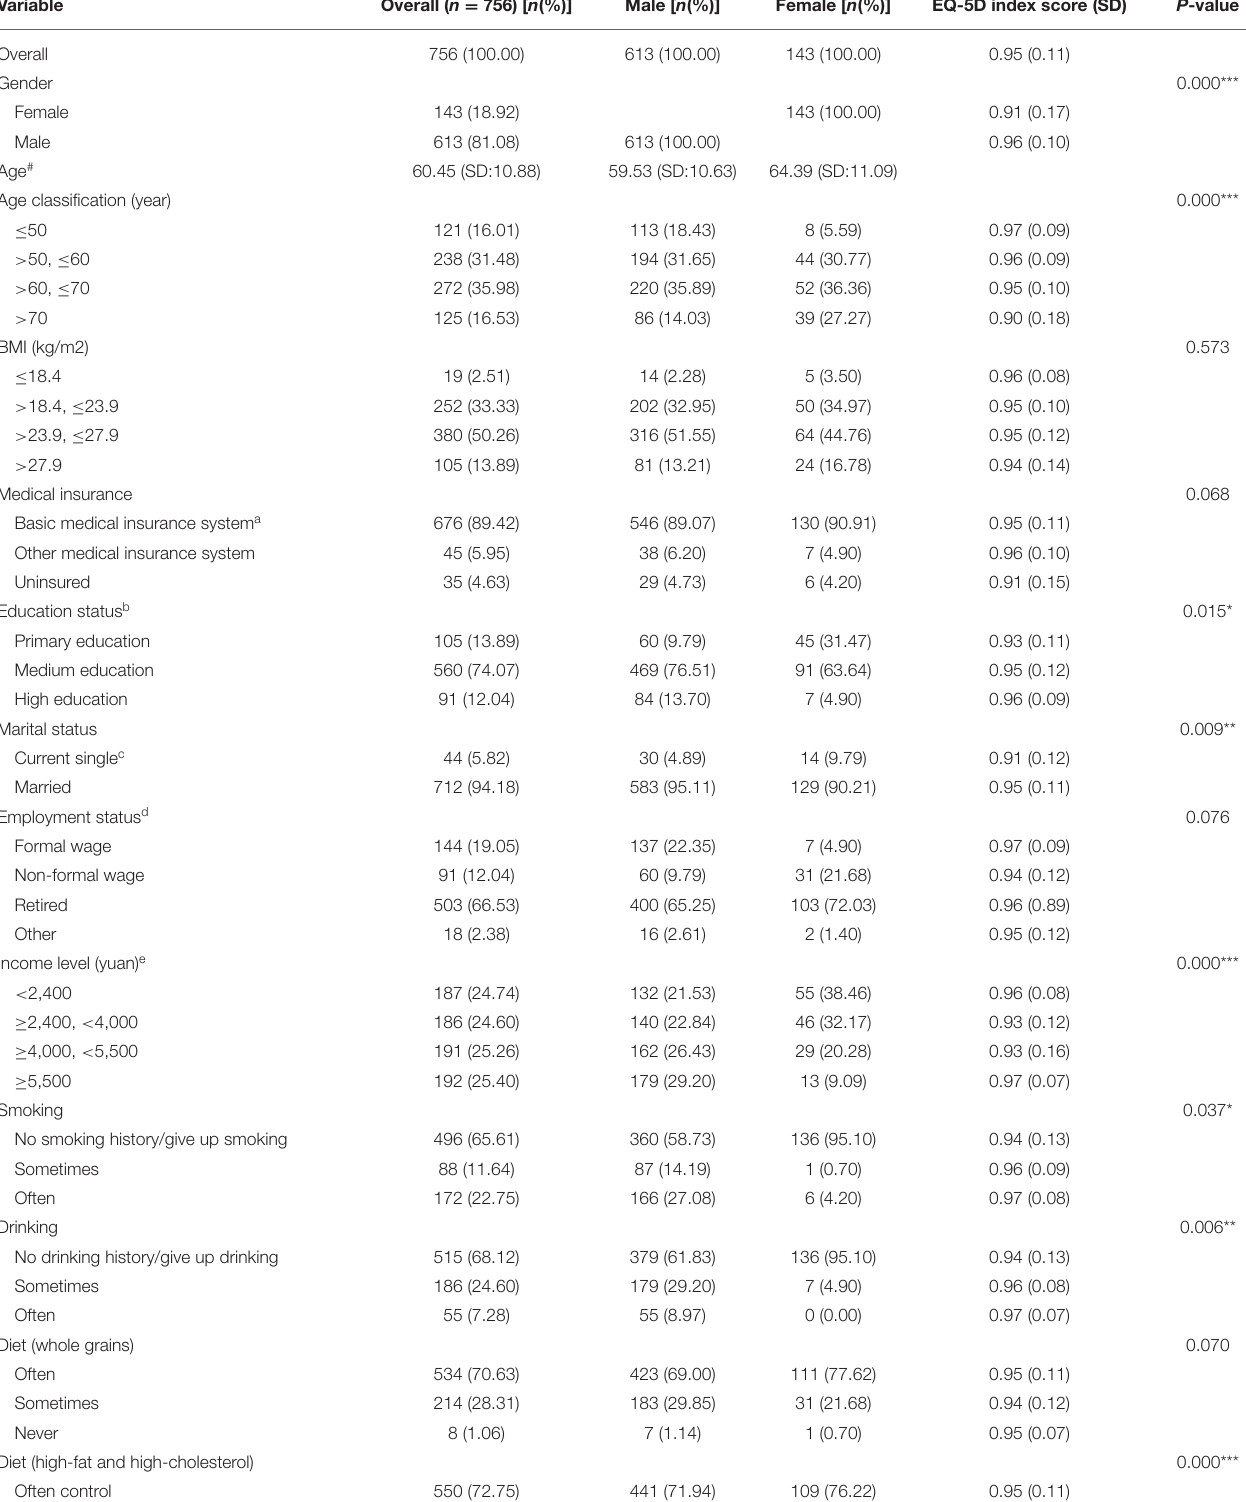
TABLE 1 | Baseline information and EQ-5D index score of all patients.